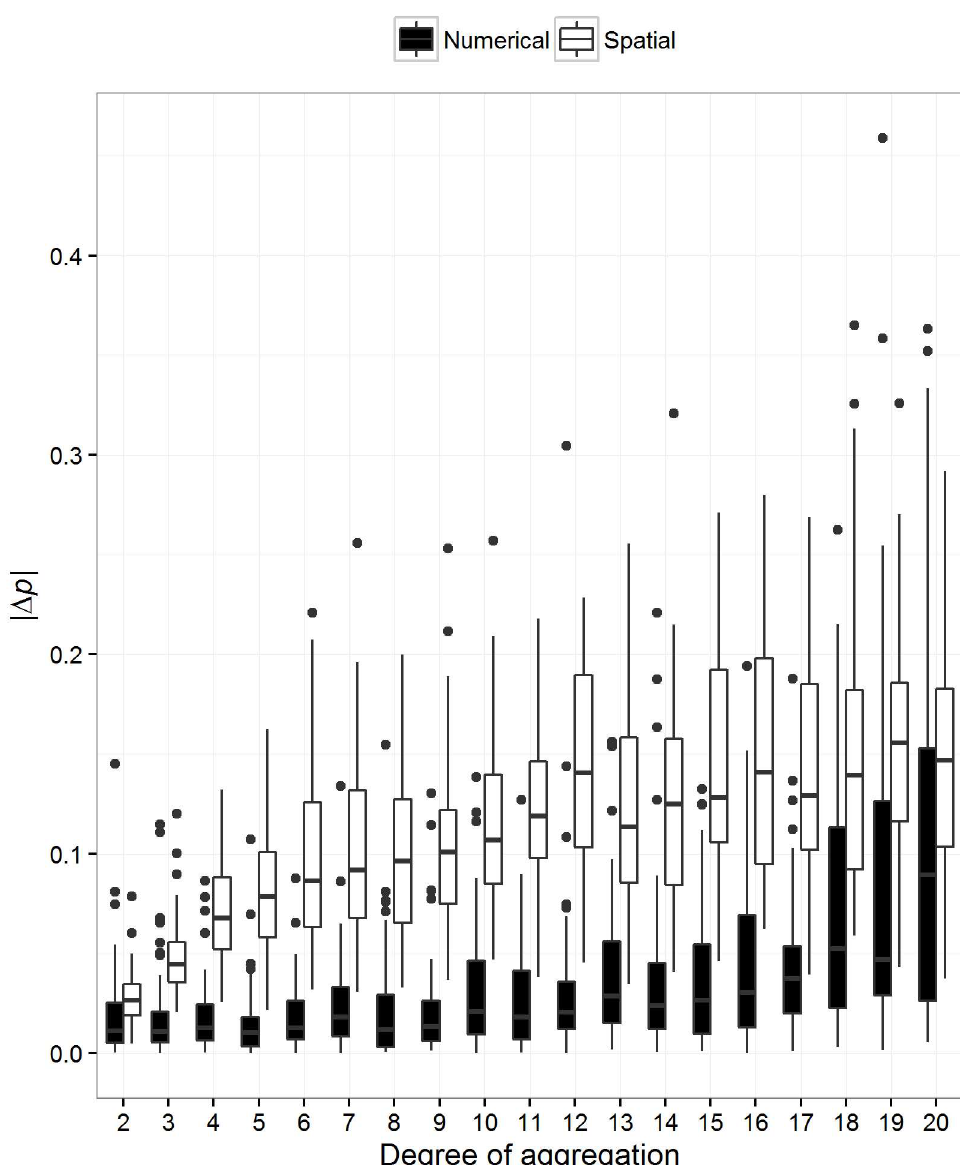
Fig 6. The effect of both spatial and thematic aggregation across methods. The effect of aggregation on the relationshipbetweenleast-cost and resistance distance. One thousandlandscapes were simulatedwith varying degreesof spatial autocorrelation and least-cost and resistancedistancewere calculatedbetween15 sites. The Spearman’srank correlation( p ) betweenthese methods was then calculated. These landscapes were then, in parallel,spatiallyand thematicallyaggregatedby a randomfactor between2 and 20. Pairwise distances were once again calculatedand subsequently the rank correlations.We then deductedthese subsequent rank correlationsfrom the baselinecorrelations.Thus, | Δ p | is the absolute changein rank correlationbetweenmethods after aggregation. The degreeof spatial aggregation is simply the spatial aggregationfactor. The degreeof thematic aggregationis ‘22—the number of discrete classes’. This means that if cost values were aggregatedinto 2 discrete classes the degreeof thematic aggregationwas 20. This figure illustrates that both spatial and thematic aggregationincrease the difference betweenthe rankings of the distances of both methods. Consequently, these methods increasingly disagreeas aggregationincreases.